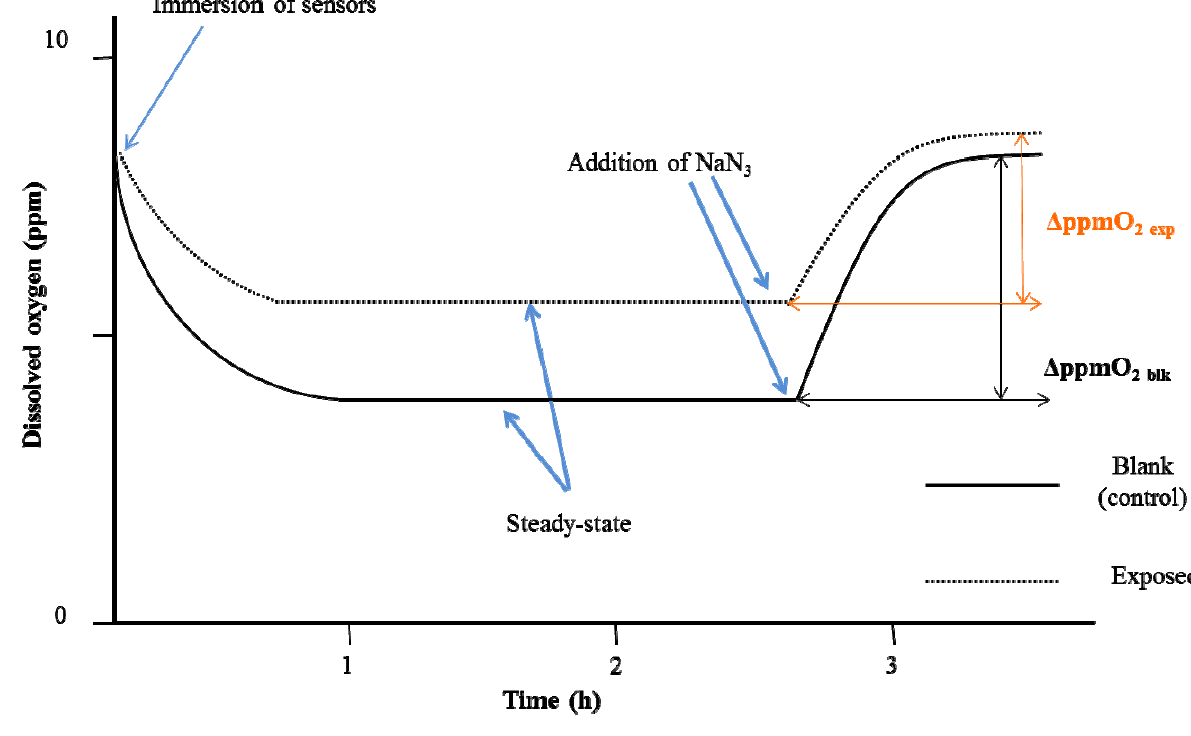
Figure 1. The experimental respirometric curve shows the dissolved oxygen (ppm O 2 ) as a function of time in the case of interference with the respiration of the yeast